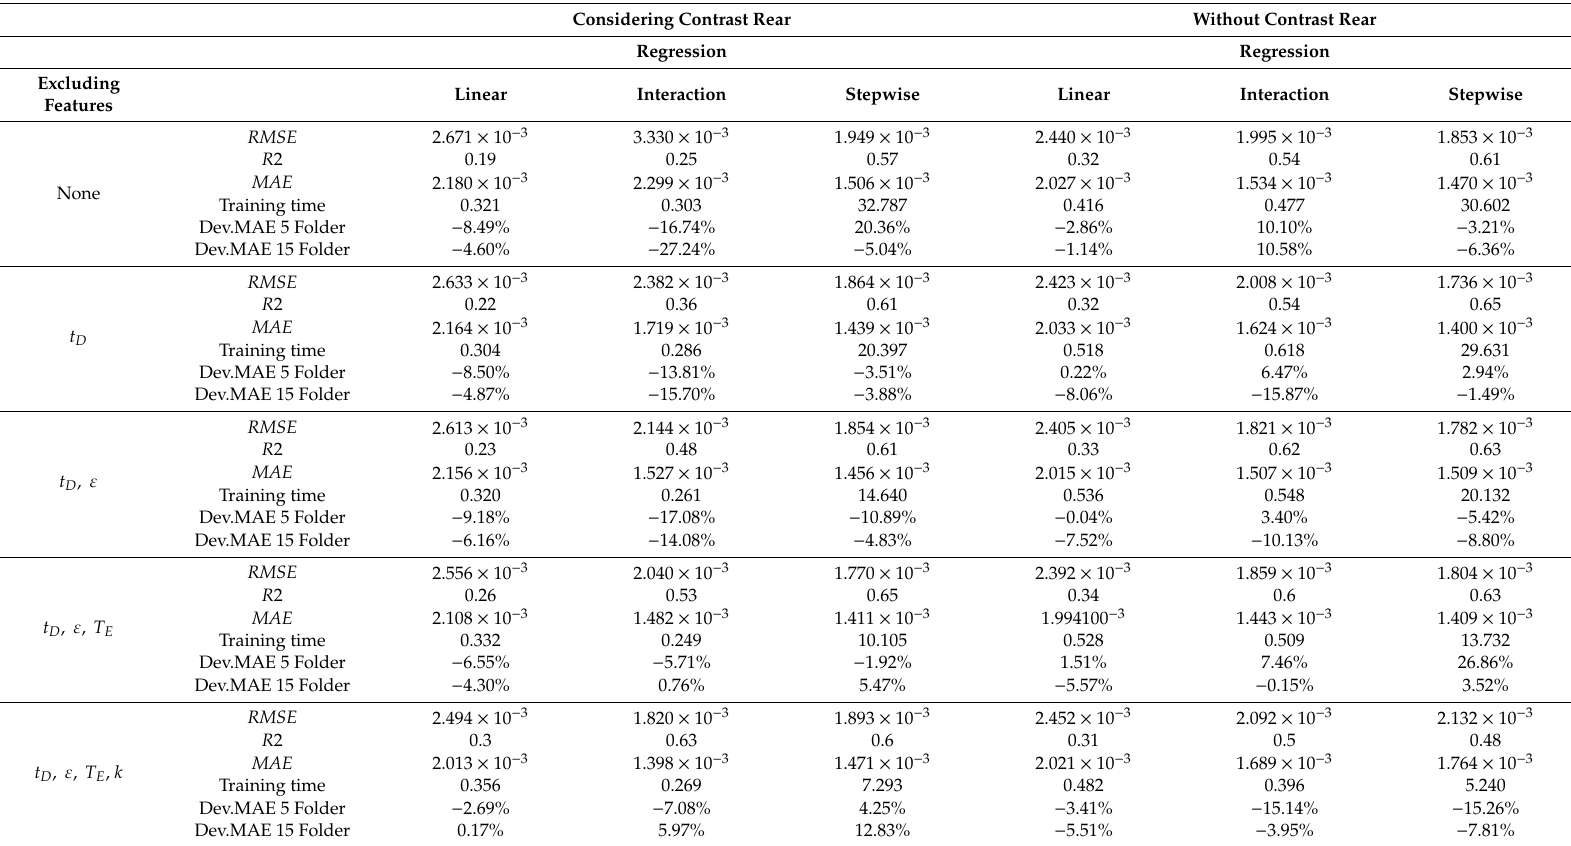
Table A2. Performance results for defect length predictor models using dataset of 100 sets of